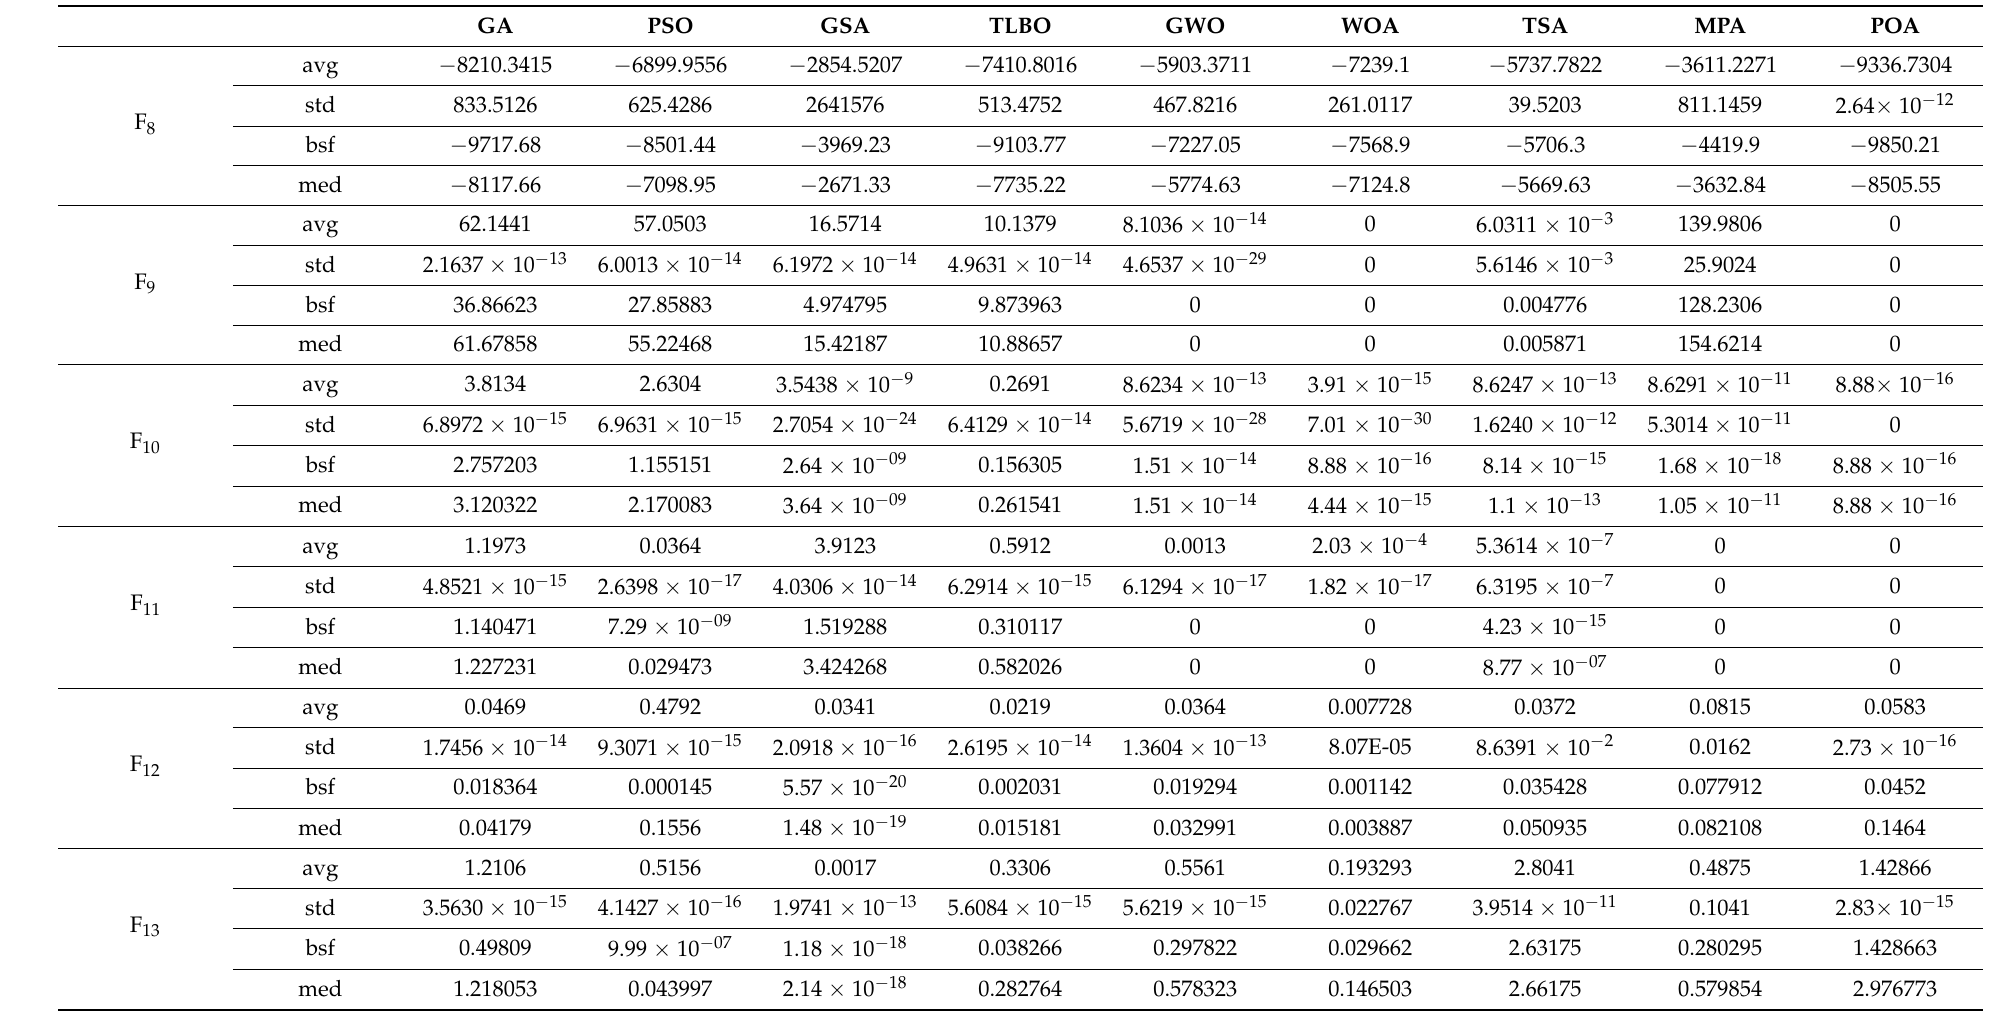
Table 3. Evaluation results of high-dimensional multimodal